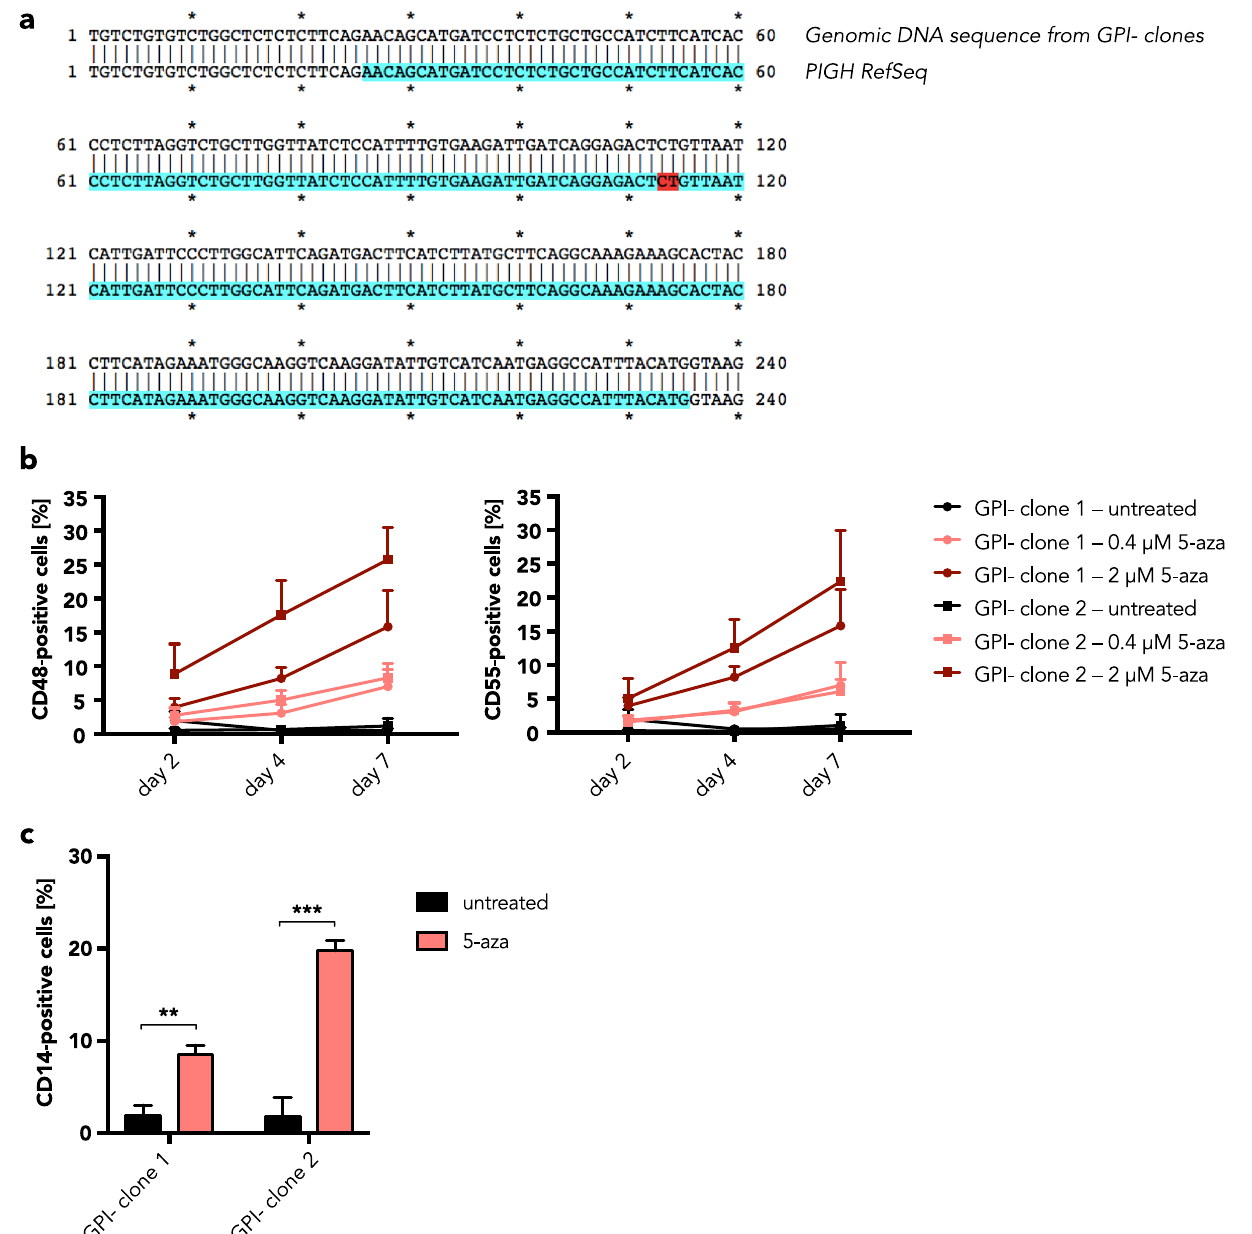
Figure 5. PIGH is epigenetically downregulated in GPI-negative BLaER1 cells. ( a ) Alignment of the PIGH locus RefSeq with the Sanger sequencing result for genomic DNA from the GPI-negative clones. Exon 2 is depicted in blue. The two nucleotides that are deleted in the PIGHP1 sequence are shown in red. ( b ) Two GPI- negative BLaER1 monoclonal cell lines (1, circle and 2, square) were treated with 0.4 µM (light red) or 2.0 µM (dark red) 5-aza-2 ′ -deoxycytidine (5-aza) or left untreated (black) for 2, 4, and 7 days. The percentage of CD48- or CD55-positive cells among GFP-expressing cells was determined by FACS analysis. Shown is the mean + SD of data from n = 3 independent experiments. ( c ) After treatment of GPI-negative BLaER1 monoclonal cell lines with 0.4 µM 5-aza or leaving them untreated for 4 days, cells were transdifferentiated for 5 days. The percentage of CD14-positive cells among GFP-expressing cells was determined by FACS analysis. Shown is the mean + SD of data from n = 3 independent experiments. 5-aza-treated cells were compared to untreated control cells using unpaired t tests (** p ≤ 0.01, *** p ≤